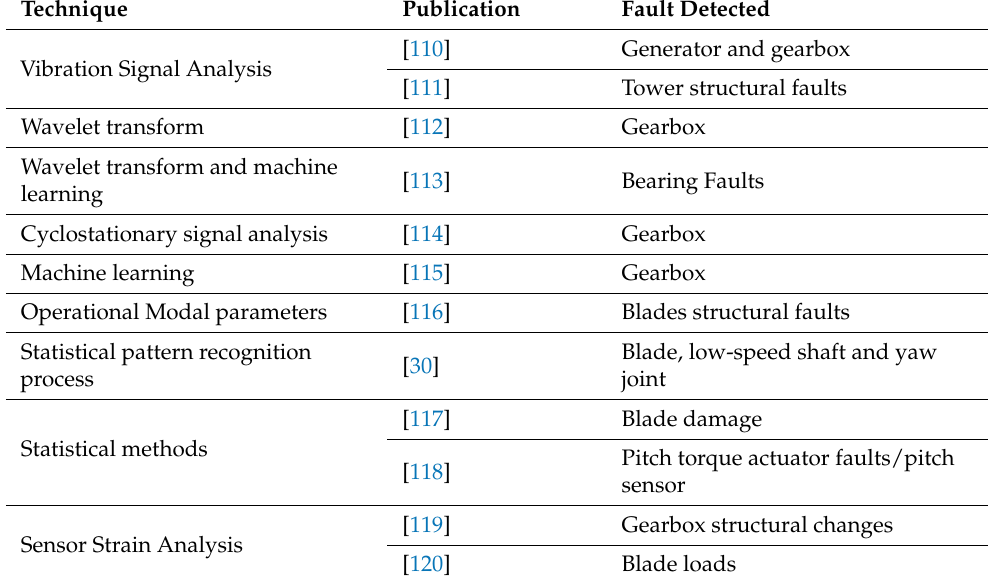
Table 4. List of some of the most relevant signal-based FDD